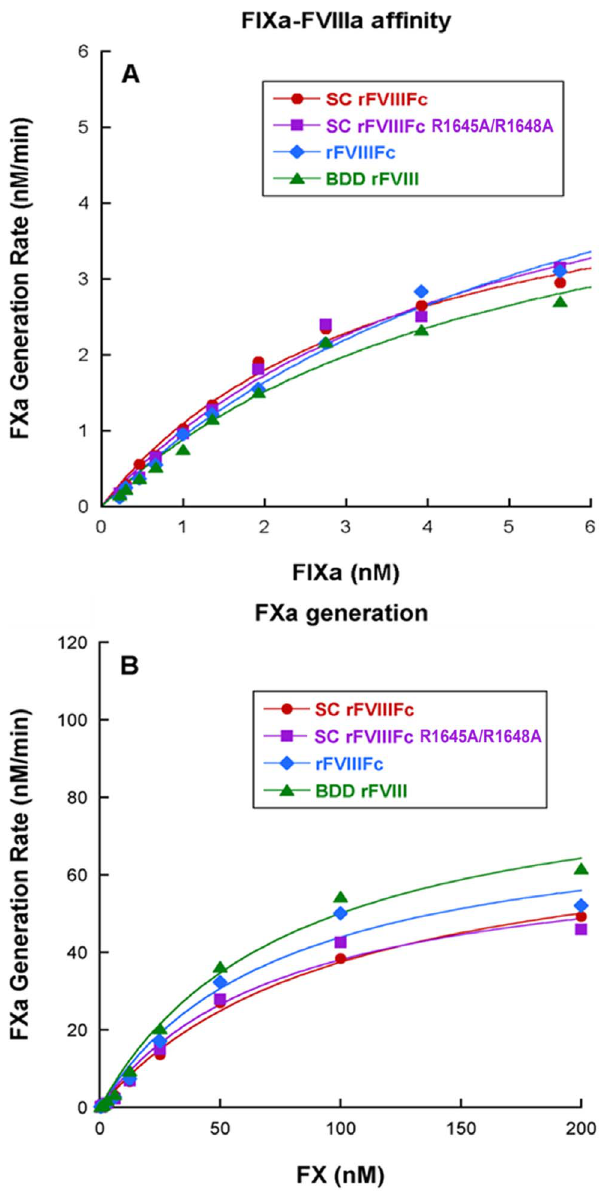
Figure 3. Activity within FXa generation assays. (A) Affinity of FIXa to different FVIII molecules on synthetic phospholipids surface (B) FXa generation rates for Xase Complexes formed with different FVIII molecules. A representative curve is shown. All results are listed in Table